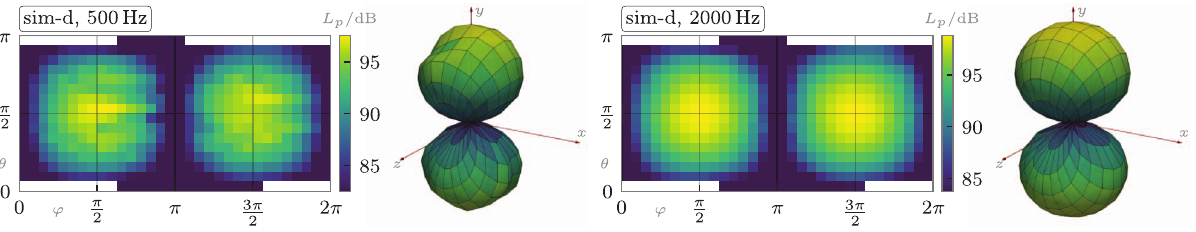
Figure 11. Simulated dipole: visualization of the directional sound radiation using the EA 512 grid, evaluated for two octave